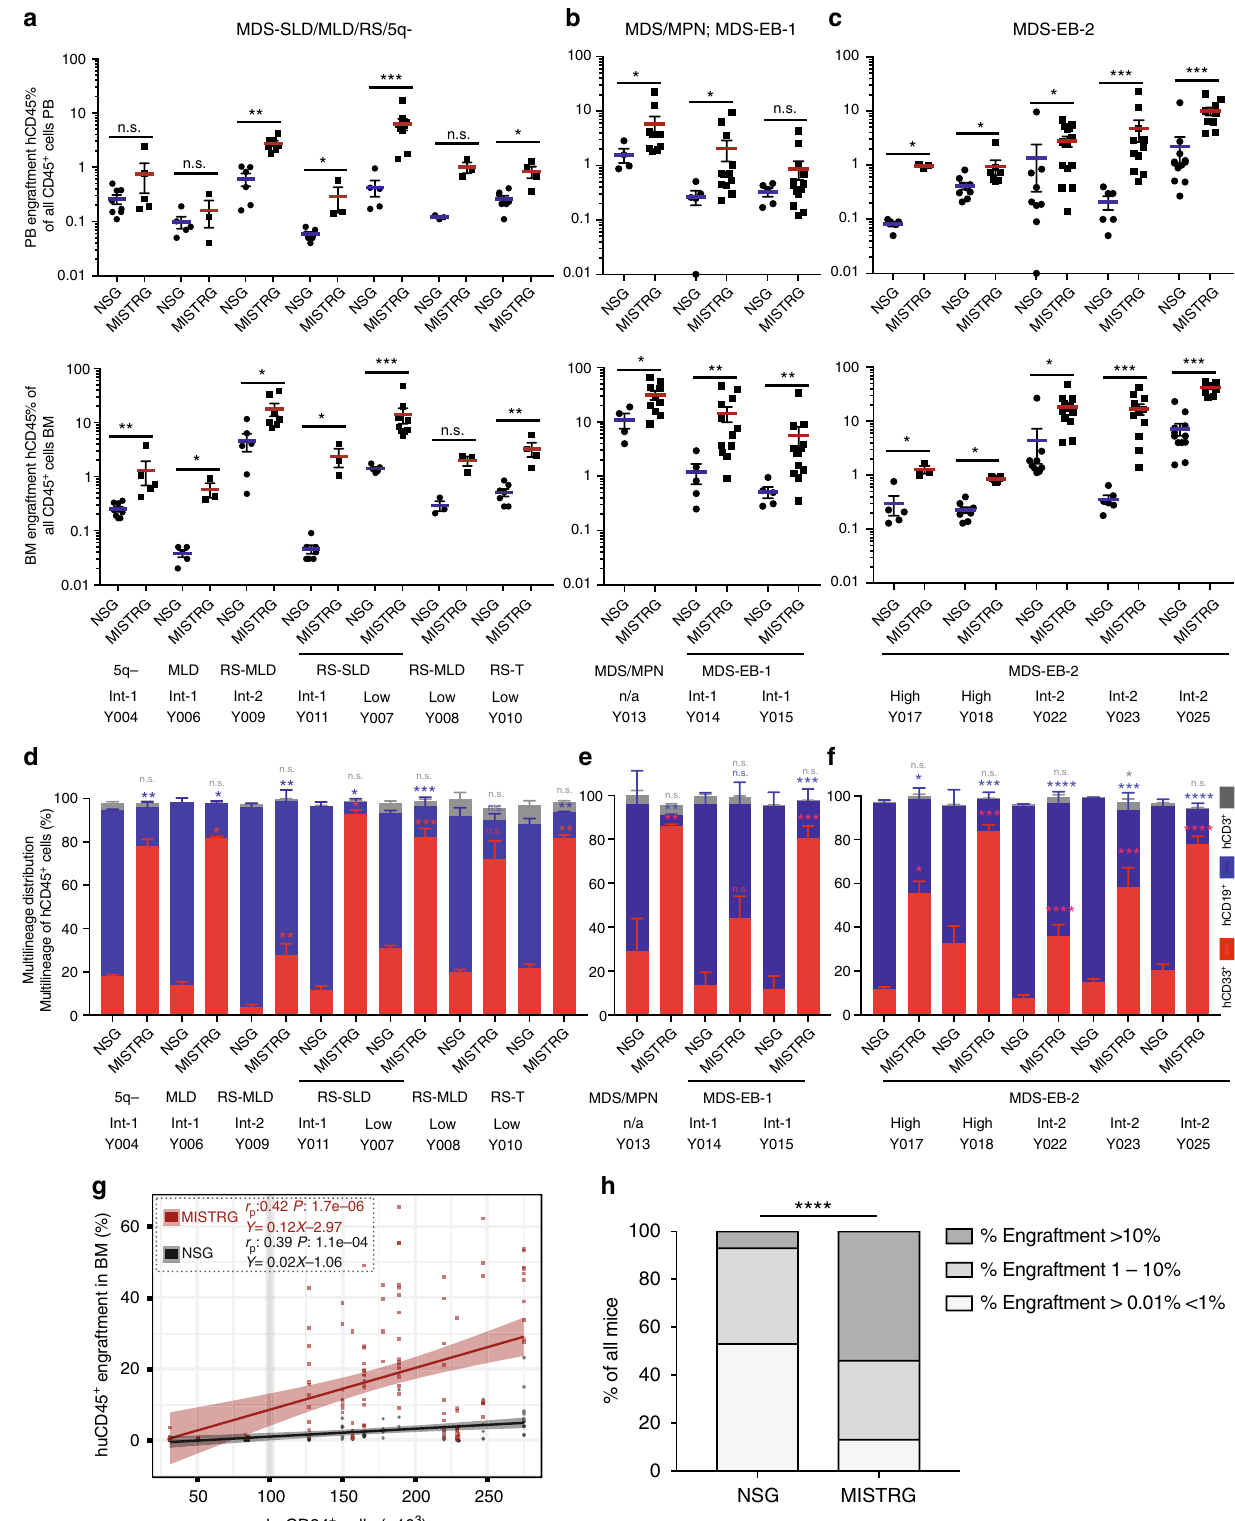
described previously for normal hematopoiesis, CD34 + cells from MDS bone marrow give rise to myeloid predominant grafts, while NSG mice give rise to lymphoid-predominant grafts (Fig. 2d – f). Expression of human M-CSF, GM-CSF, and